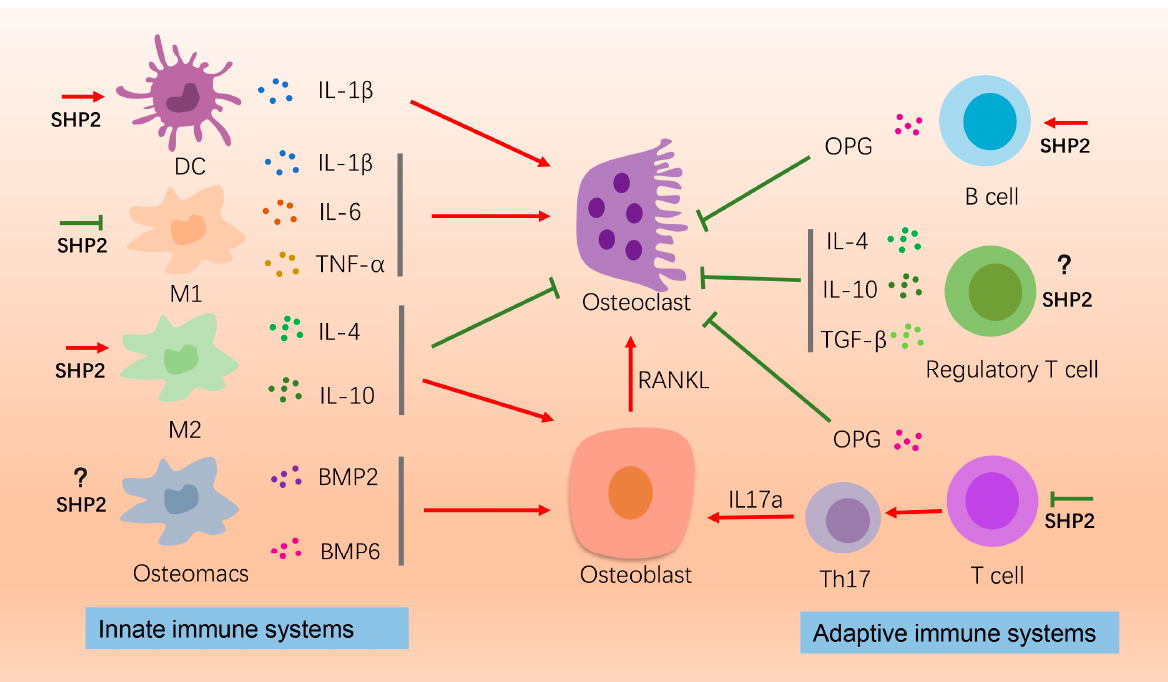
Figure 1. The effects of SHP2 on bone homeostasis by affecting immune cells. Here the roles of macrophages, B-cells, and T-cells on osteogenesis or osteoclatogenesis are depicted. IL-1 β , IL-6, TNF- α released by the M1 macrophages promote osteoclastogenesis for bone resorption. SHP2 suppresses this process. The M2 macrophages secrete IL-4 and IL-10 to promote bone formation and suppress bone resorption. SHP2 enhances this process. Osteomacs produce BMP2 and BMP6 to promote bone formation. The effect of SHP2 on osteomacs is unknown. B-cells produce OPG to inhibit osteoclastogenesis and SHP2 promotes pre-B cells proliferation. Regulatory T cell releases IL-4, IL-10 and TNF- α to inhibit osteoclastogenesis. T cells, on the one hand, produce OPG to inhibit osteoclasts, and on the other hand differentiate into TH17, promoting osteoblast activity by producing IL-17 α . This process is inhibited by SHP2. “Red arrow” refers to promotion; “Green arrow” refers to inhibition.